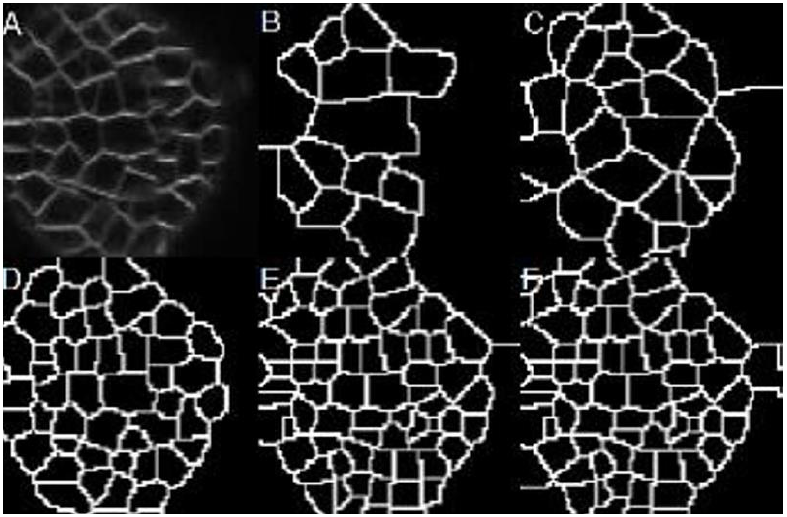
Figure 4. Variation of the segmentation results by varying h in the proposed algorithm in the range. ( A ) Original image. ( B , C ) Under-segmented images. ( D ) Best-segmented image. ( E , F ) Over-segmented images. The best segmented image, in this example, was chosen by visual evaluation and is the one in which a greater coincidence was observed between the edges of the original meristem image and those of the resulting image.